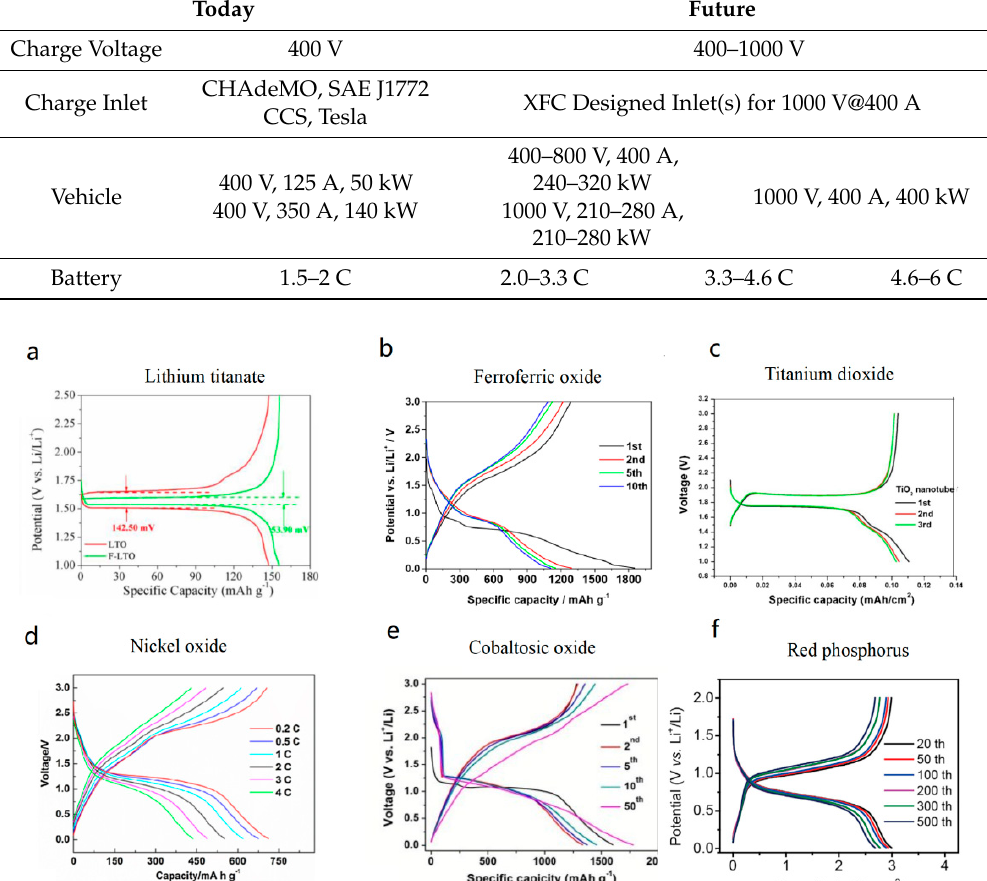
Table 4. Timeline of BEVs and battery C-rate to support XFC. Reproduced with permission from [4].